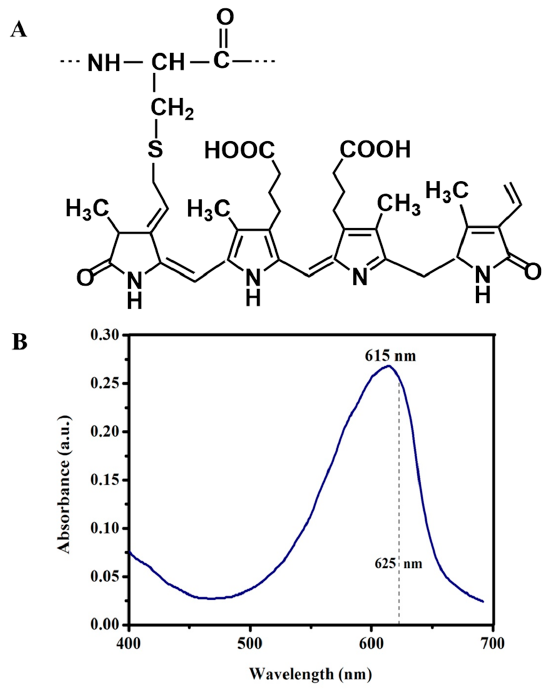
Figure 1. Chemical structure and absorbance spectrum; ( A ) Chemical structure of c-phycocyanin; and ( B ) UV-VIS absorbance spectrum of c-phycocyanin dissolved in water at the concentration of 10 μ g·mL − 1 .